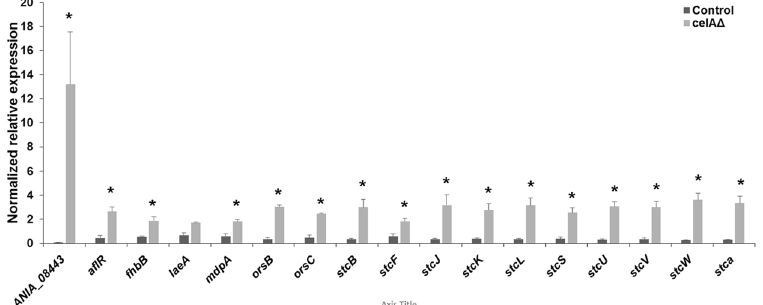
Figure 5. RT-qPCR analysis on ANIA_08443 and a set of secondary metabolism-related genes in the control and celA Δ strain. The data were normalized using rpl3 and CRP2 . Asterisks indicate statistically significant differences ( p <